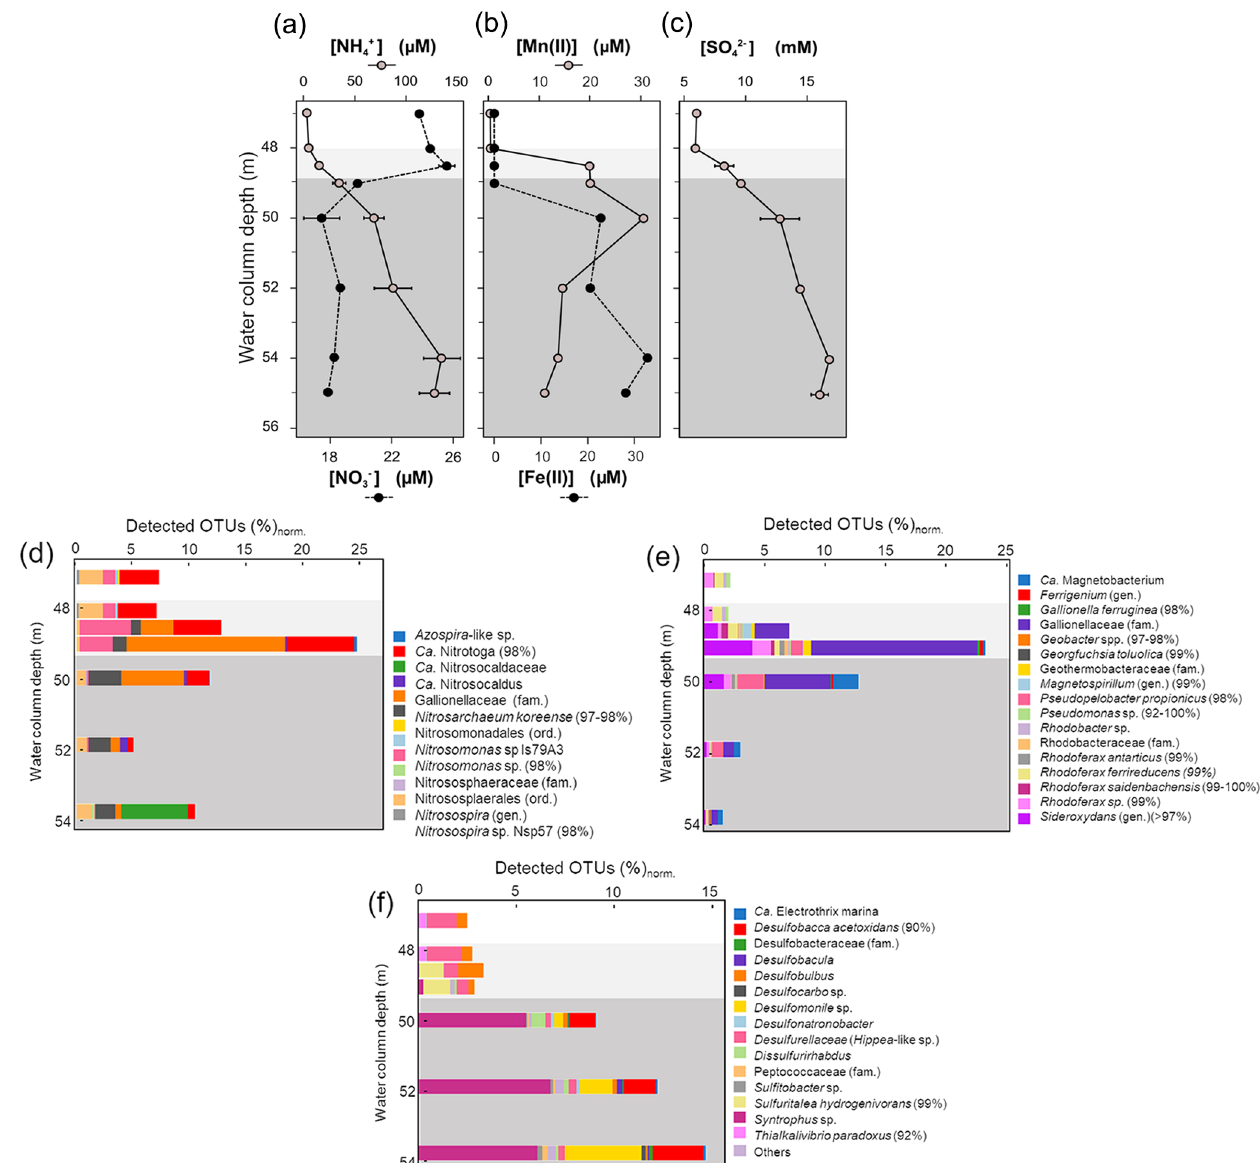
Figure 4. Measured dissolved concentrations of nitrate and ammonia (a) , manganous manganese and ferrous iron (b) , and sulfate (c) in the bottom water column of Lake Medard (central sampling location). The right-side panels show the corresponding, normalized abundance of putative planktonic nitrogen (d) , iron (e) , and sulfur-utilizing (f) prokaryotes. Sequences were classified based on best BLAST (basic local alignment search tool) hit results, and bacteria/archaea were identified based on phylogenetic affiliations. Normalization was with regard to total amplicon reads in each sample. Grey background colours are based on the Eh profile (Fig. 2) and here also indicate redox-stratified niches. The sequences were deposited in the European Nucleotide Archive EMBL-EBI